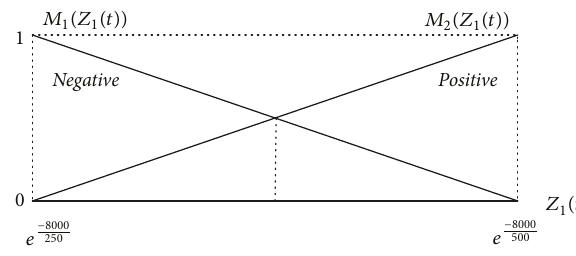
Figure 2: Membership functions 𝑀 1 (𝑍 1 (𝑡)) and 𝑀 2 (𝑍 1 (𝑡)) .